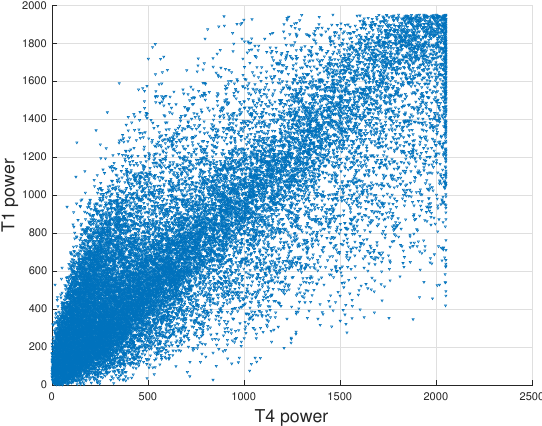
Figure 6. y (power of T1) as a function of the first principal component of the covariatives matrix. D bef data set.